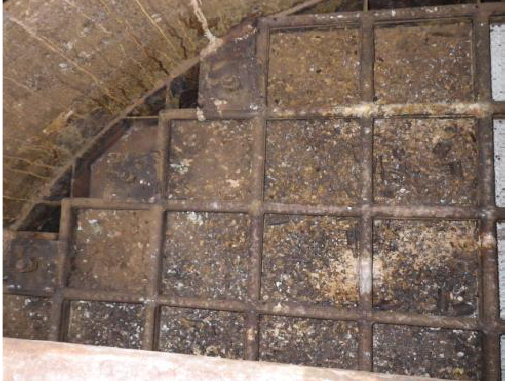
Figure 7. Catalyst blocks clogged by scales of rust [28].